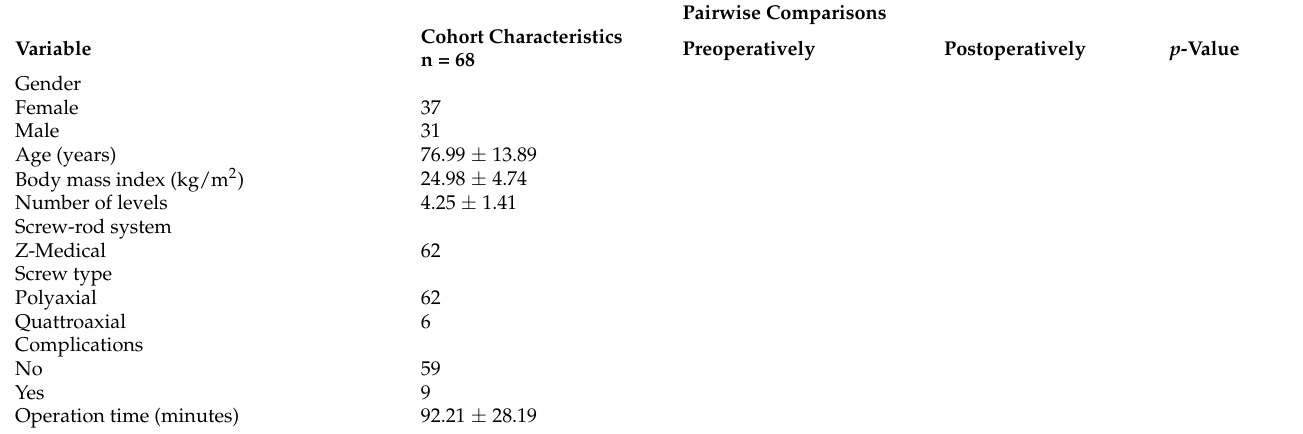
Table 1. Description of clinical and laboratory characteristics in the cohort (n = 68) and pairwise comparisons of preoperative versus postoperative (1 day) laboratory values. Wilcoxon signed-rank test was used for pairwise comparison. Data are presented as mean ± standard